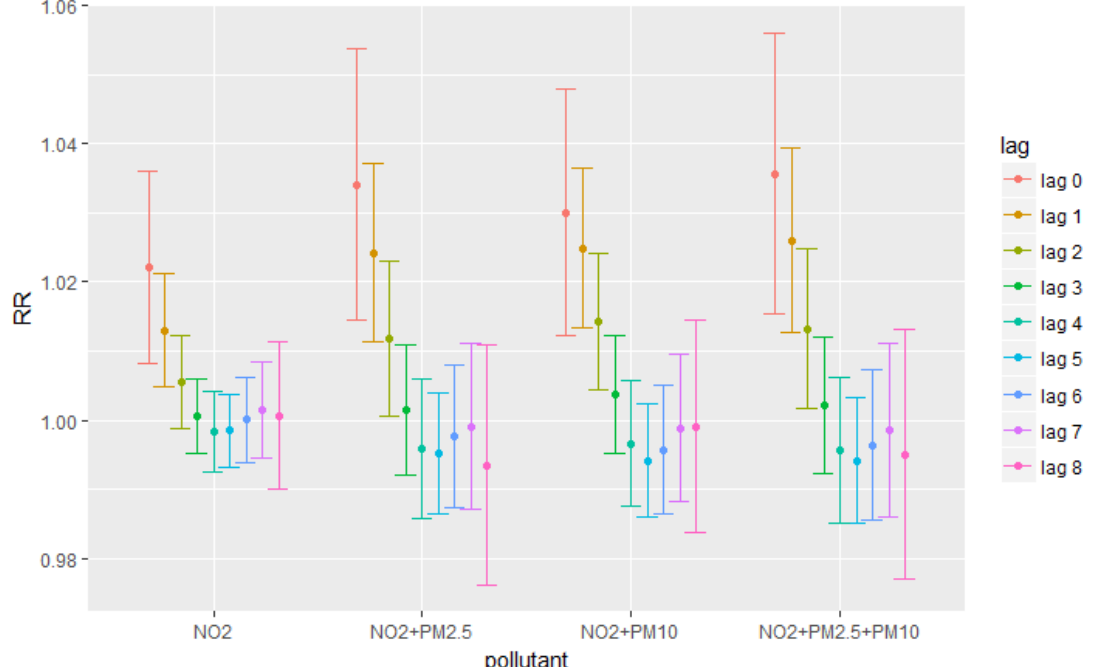
Figure 2. Relative Risks for different pollutants combination at each lag.